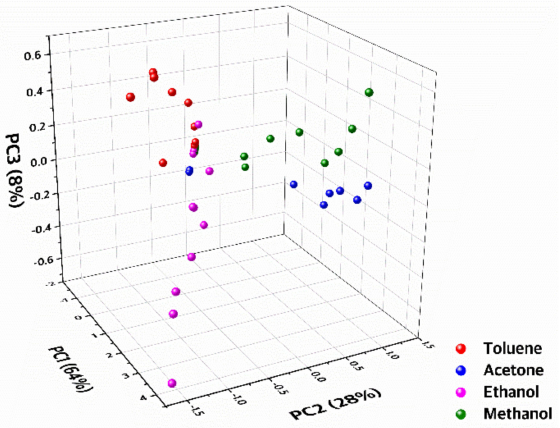
Figure 7. 3D PCA plot of a data set composed of maximum frequencies and fall and rise times of three CMUT sensors coated with different chemically sensitive layers in response to various concentrations of four VOCs.